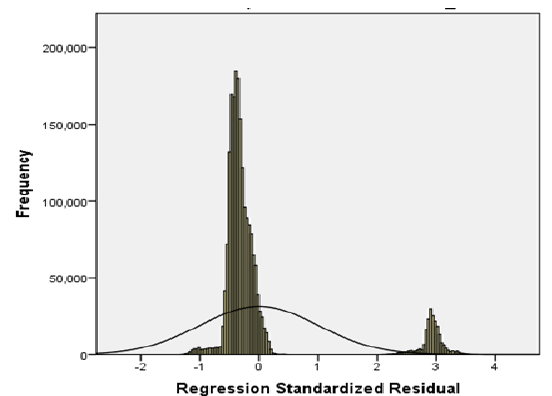
Figure 5. Result of normality